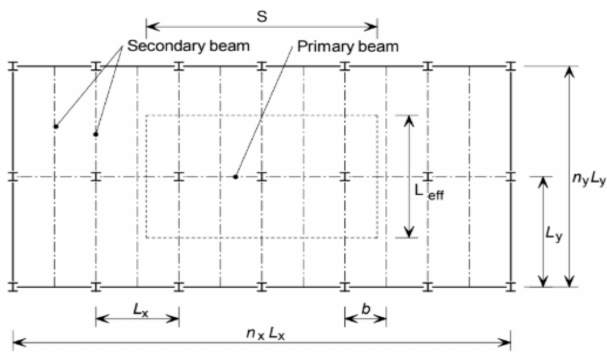
L y = the span o f the secondary beams ( Figure 3.4.2 ) .